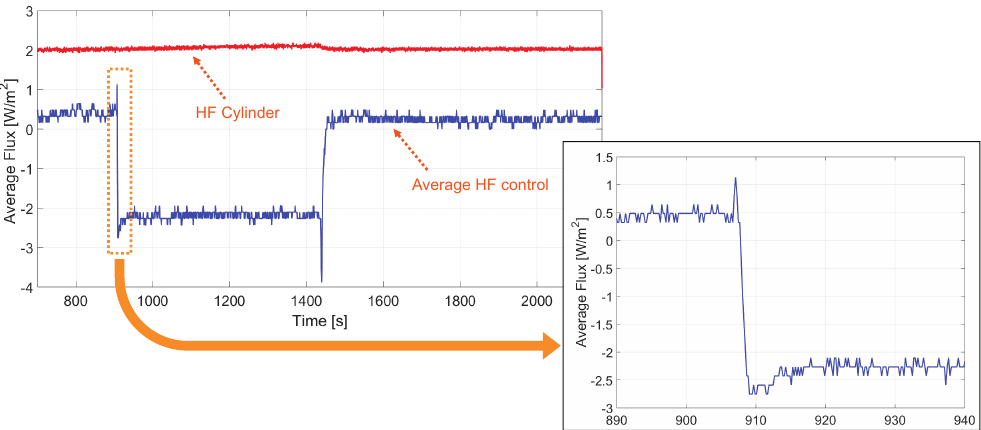
Figure 13. Evolution with time of the control-generated and the cylinder heat fluxes in the closed-loop experiment. The thermopile was placed on top of the cylinder at t = 907 s and removed at t = 1430 s. The cylinder heat flux monitored by the PT500s is almost constant 1.5 W/m 2 . The heat flux generated by the control compensates this heat flux change. A zoom near the first transition, t = 907 s, is also shown. Each sample is the average of 305 consecutive bits (4.9 averaged